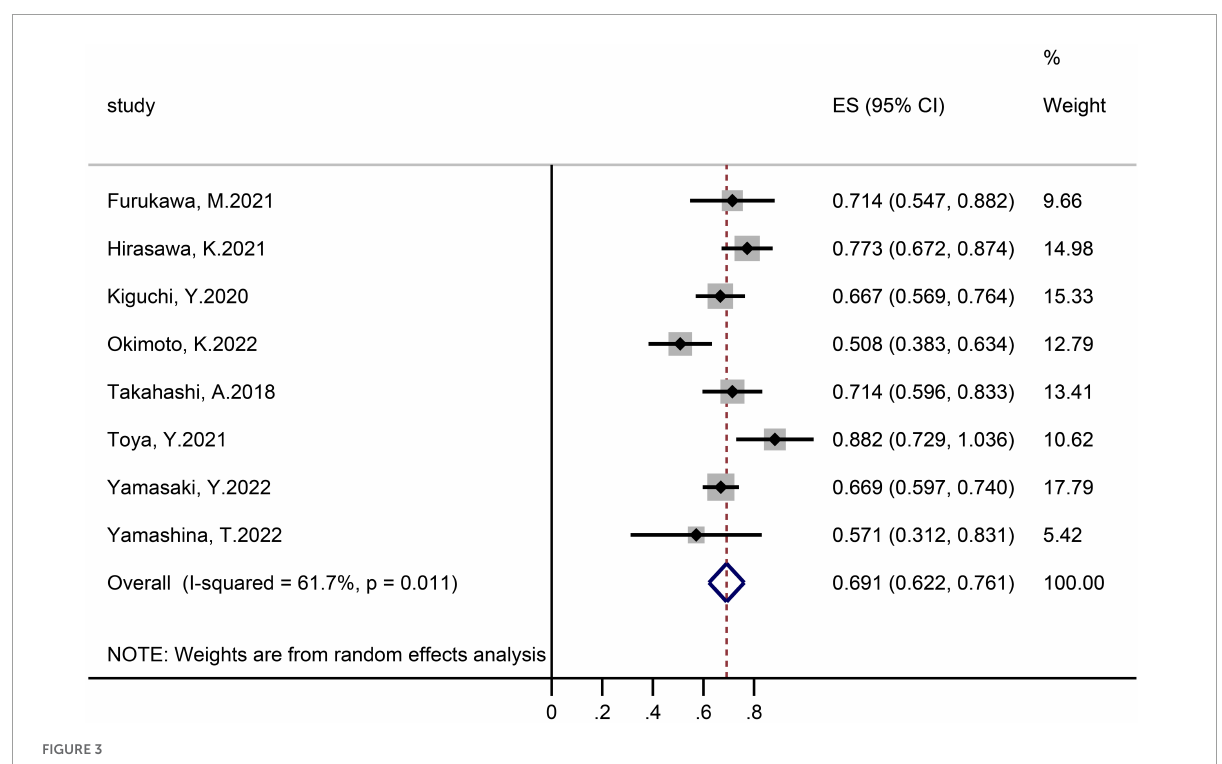
FIGURE3 Forest plot, R0 resection